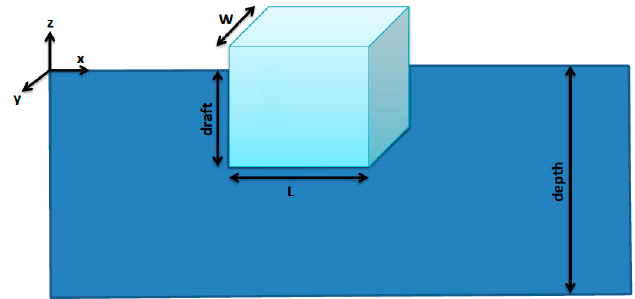
Figure 9. Description of the parallelepipedic hull shape.